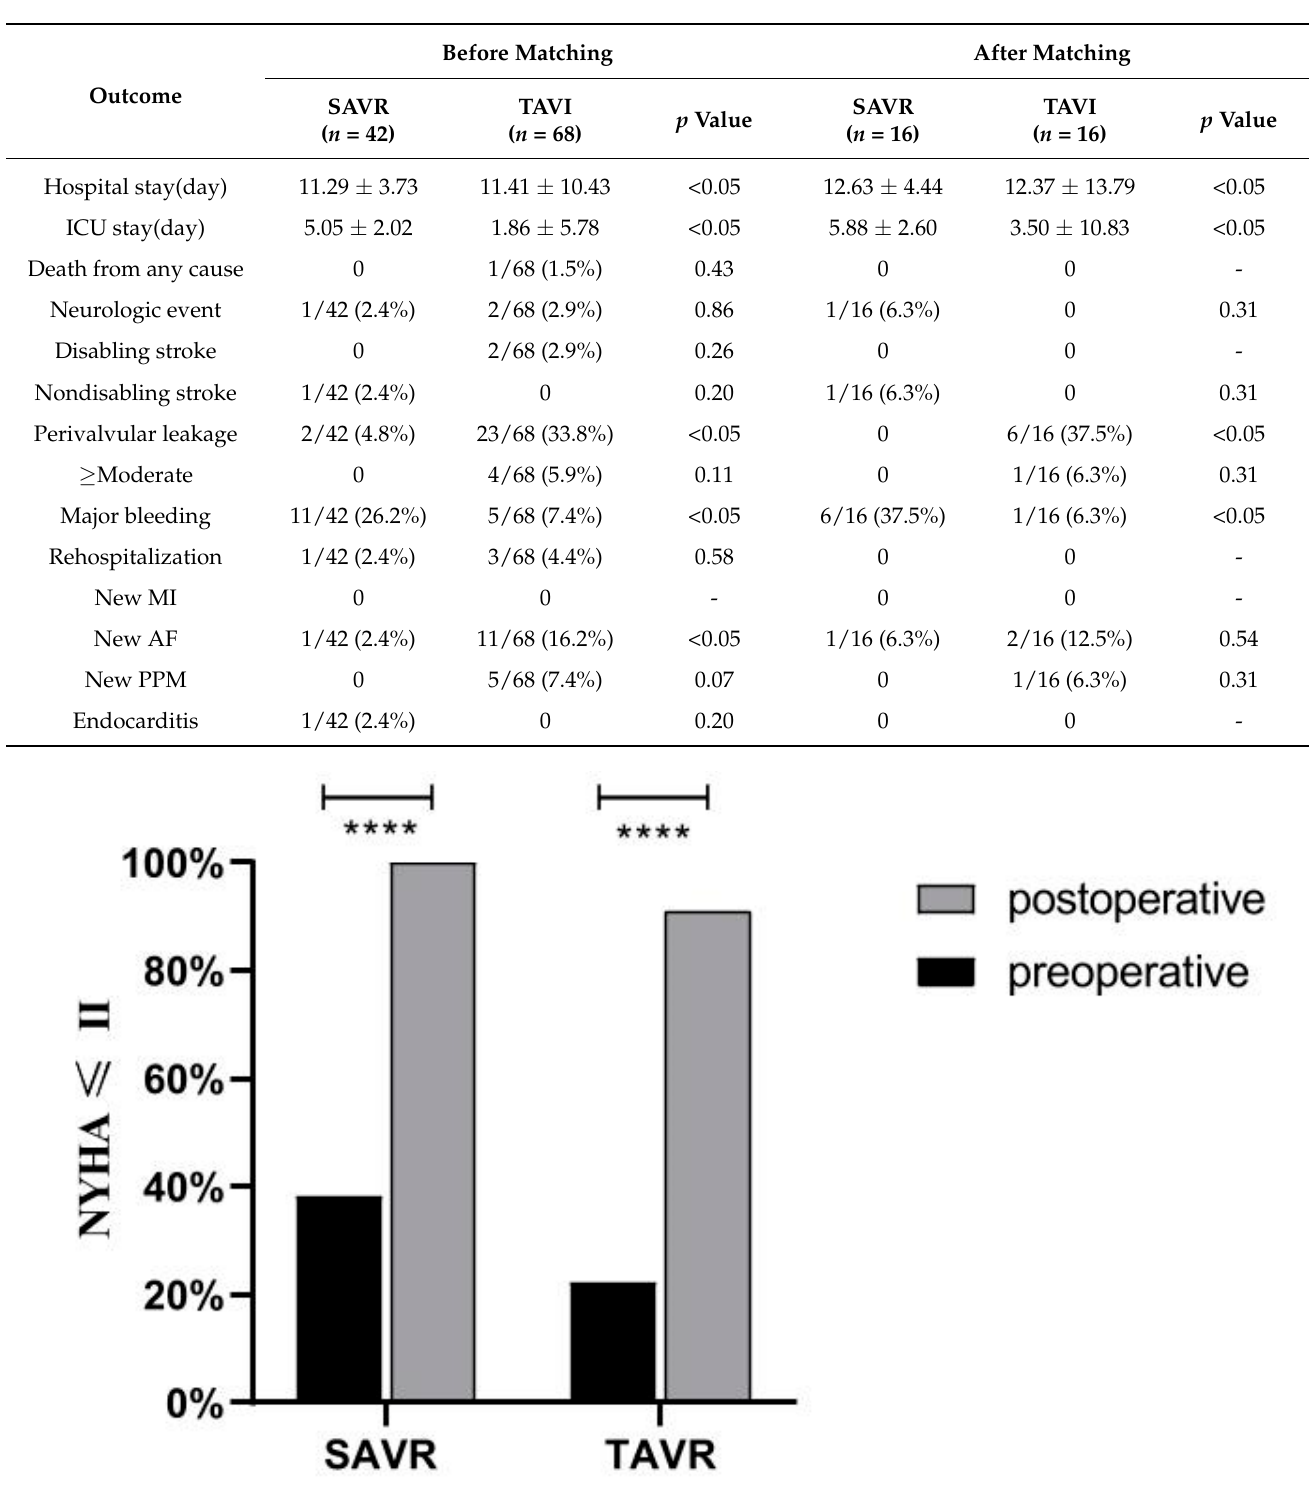
Figure 1. NYHA classification in both groups before and after procedure. **** means p ≤ 0.0001